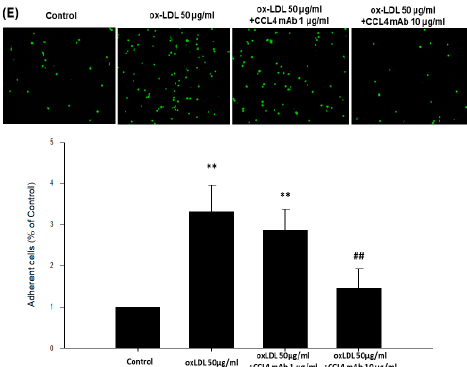
Figure 5. Inhibition of the exogenous CCL4 reduced the TNF- α - and ox-LDL-induced adhesion molecule expression and the adhesiveness of human coronary endothelial cells HCAECs. The time and dose-dependent response of HCAEC after TNF- α stimulations ( A ). Western blots and statistical analyses of E-selectin, vascular cell adhesion molecule-1 (VCAM-1), and intercellular adhesion molecule-1 (ICAM-1) expressions in HCAECs after the stimulation of TNF- α ( n = 3; B ) and ox-LDL ( n = 3; D ) for 24 h. THP-1 adhesion assay with HCAECs ( n = 3; C , E ). N represents for the number of independent experiments. * p < 0.05, ** p < 0.01 compared with the control group. # p < 0.05, ## p < 0.01 compared with the TNF- α - or ox-LDL-stimulated group.